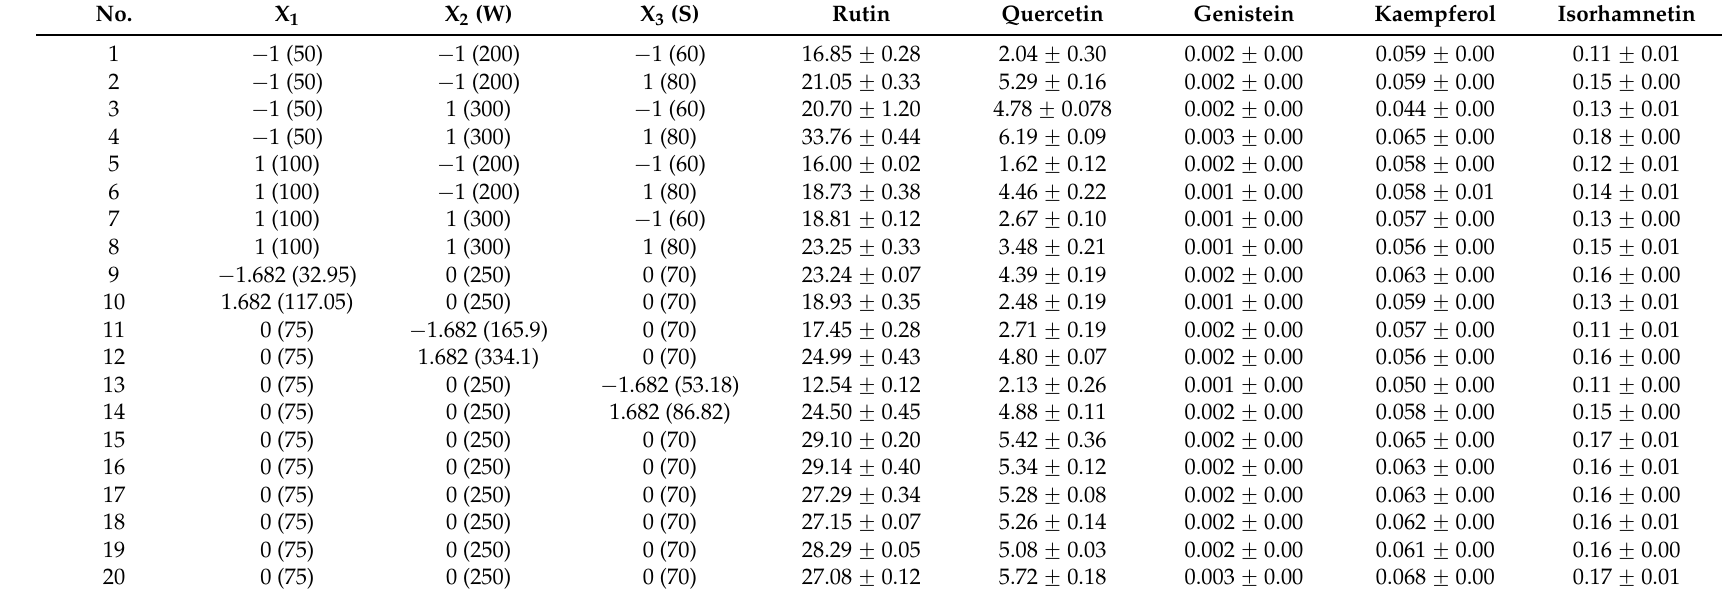
Table 2. Extraction yield of response surface CCD ( n = 3) and expressed as means ˘ SD (units: